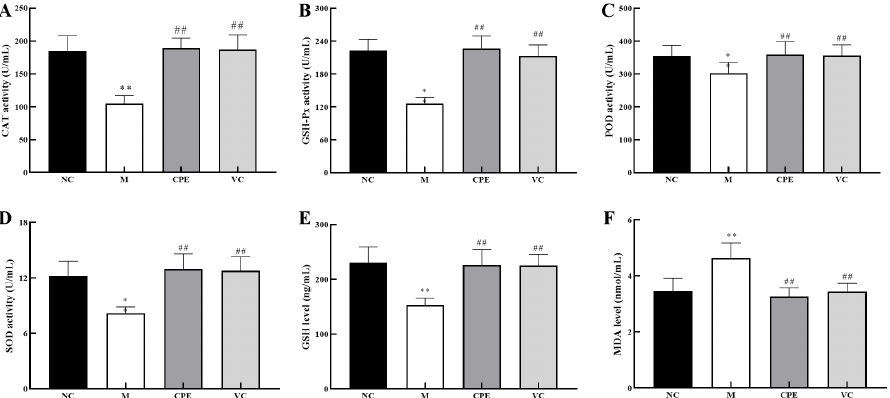
Figure 3. Antioxidant capacity of CPE in the serum. Note: ( A ): Serum CAT activity in each group;